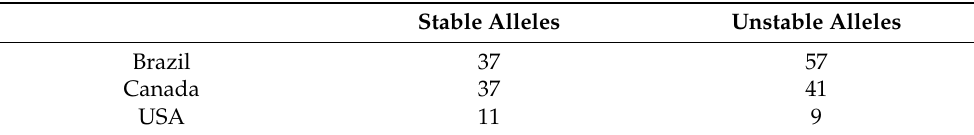
Table 2. Distribution of stable and unstable alleles in the studied cohort.